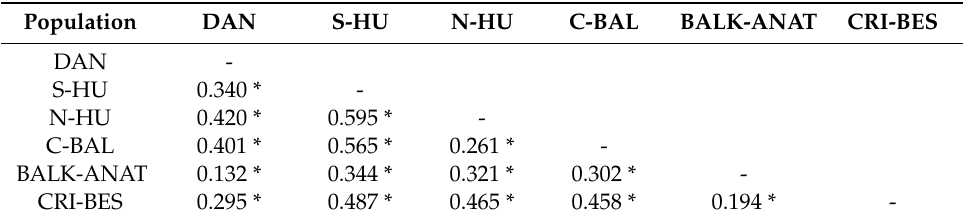
Table 2. D. caspius population pairwise F ST